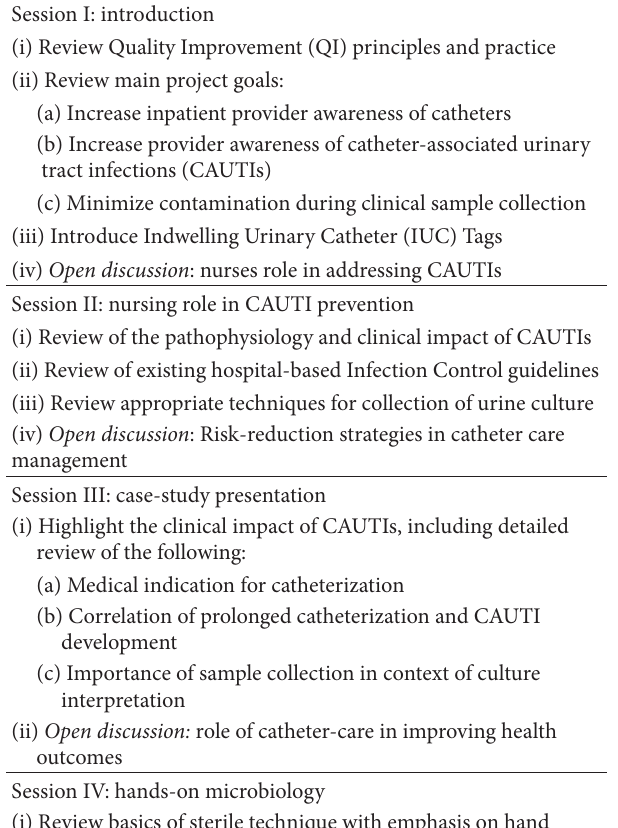
Table 1: Our targeted educational curriculum consisted of five sessions. Each session provided a format of didactic and open discussion components and opportunities for hands-on learning. The participants were inpatient nurse providers, and sessions were led by a QI educator, and nurse project champions.